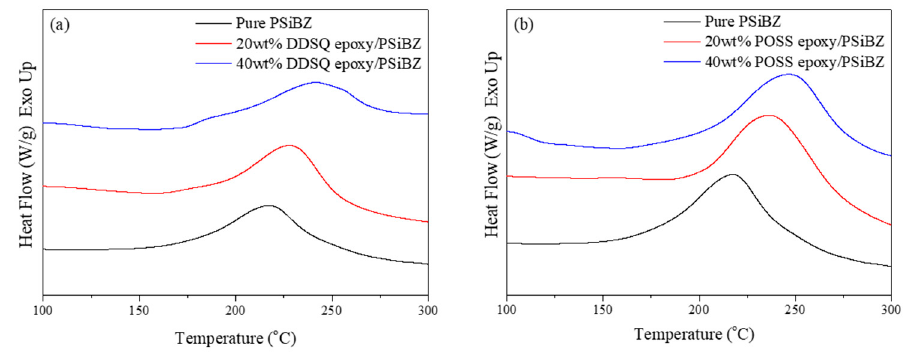
Figure 2. Exothermic curves of ( a ) DDSQ epoxy / PSiBZ and ( b ) POSS epoxy / PSiBZ nanocomposites. Table 2. Curing characteristics of pure PSiBZ, DDSQ epoxy / PSiBZ nanocomposites, and POSS epoxy / PSiBZ nanocomposites.